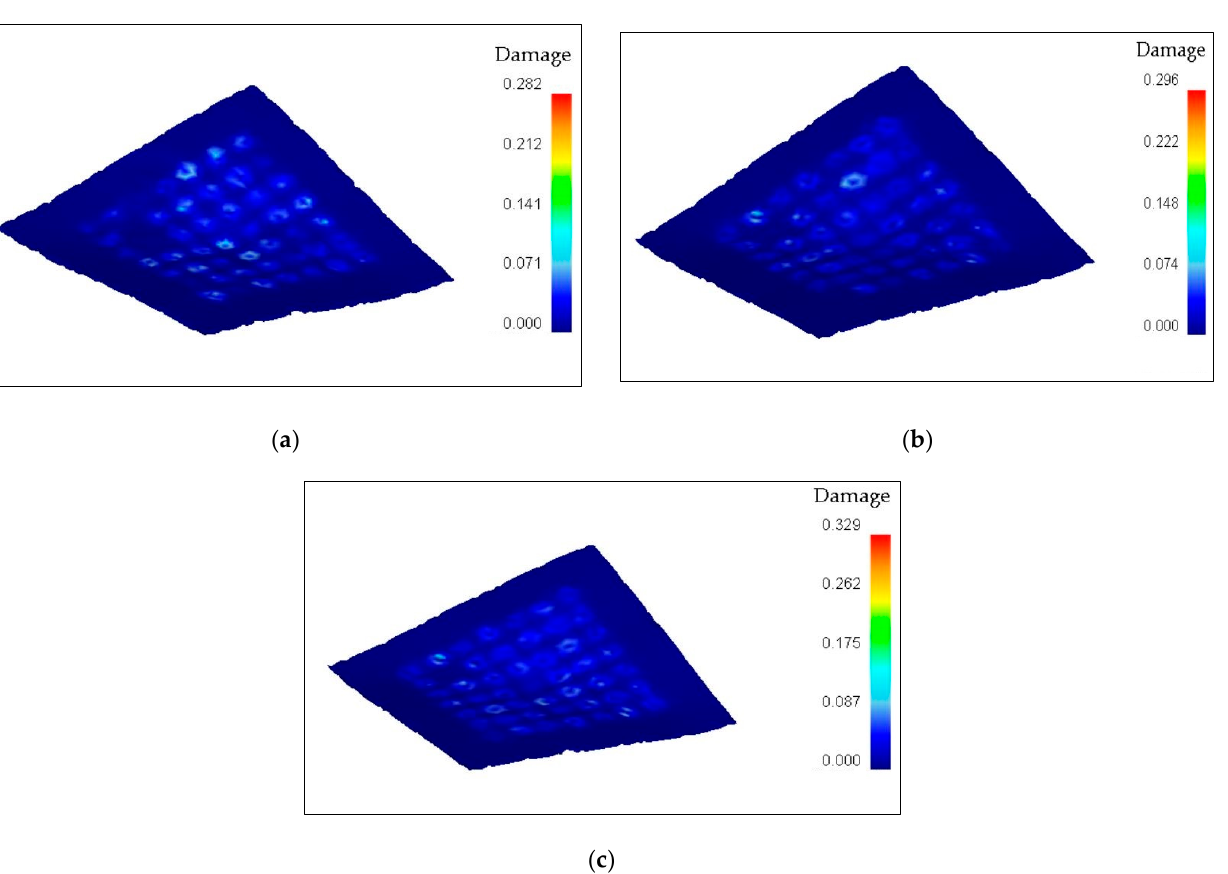
Figure 13. Damage factors of form3 with ( a ) 10 mm pins; ( b ) 12 mm pins; ( c ) 14 mm pins.